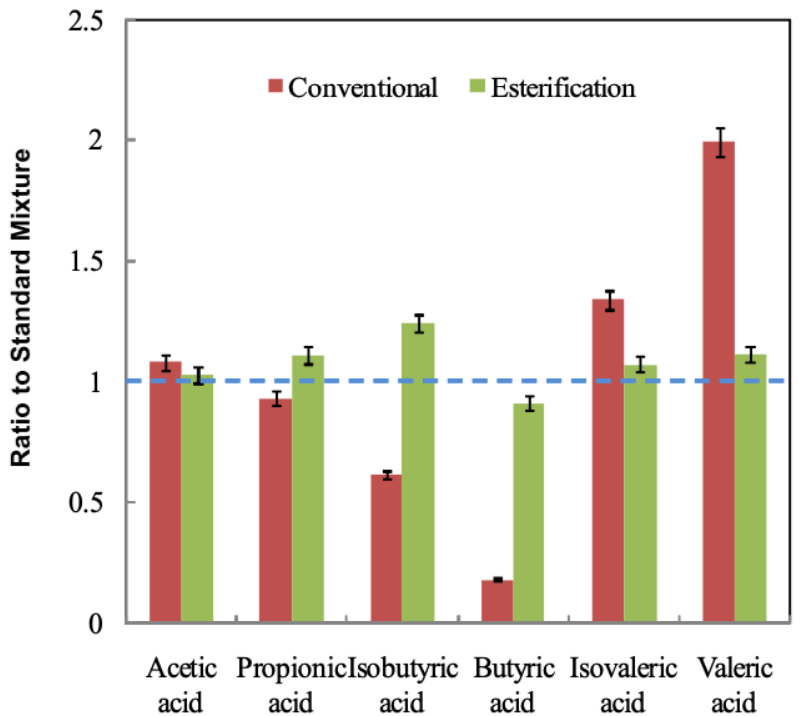
Figure 3. Ratio of the measured concentration to the known one for each component of the standard VFA solution to compare the catalytic esterification reaction method to the conventional method.